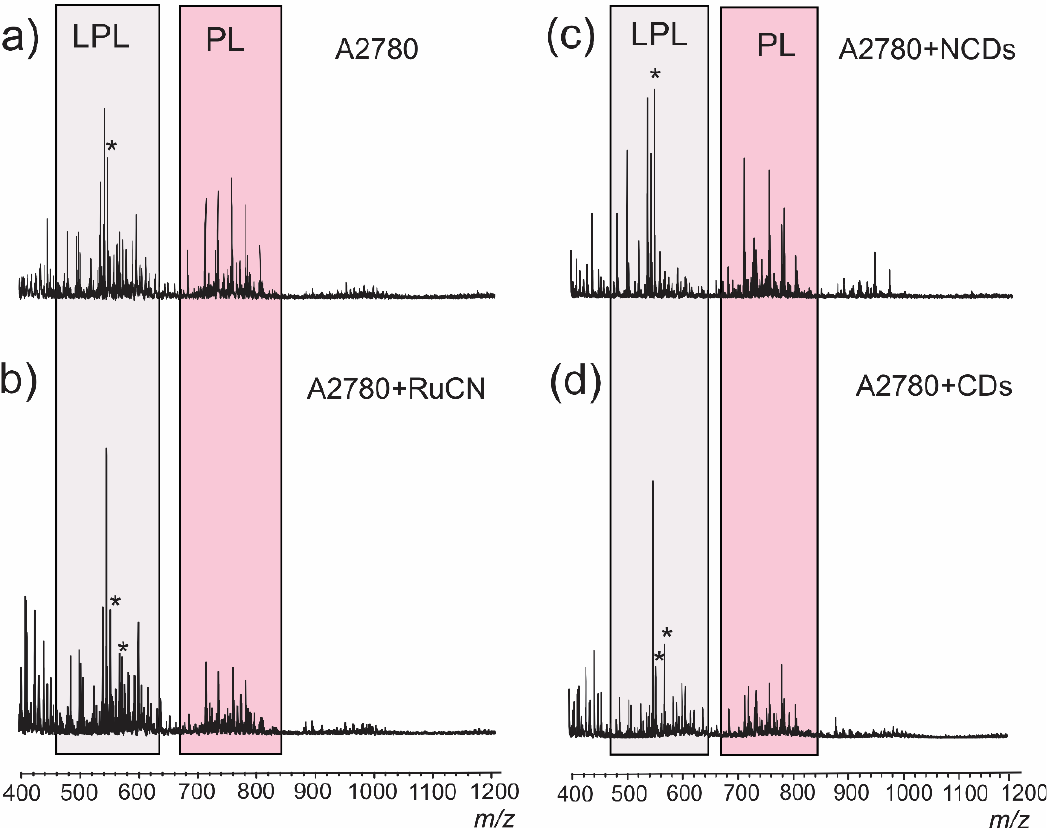
Figure 2. Positive-ion MALDI TOF mass spectra of extracted lipids from the A2780 cancer cell line ( a ) after the treatment with Ru-CN metallodrug ( b ), N-CDs ( c ), and CDs ( d ). Peaks with an asterisk (*) correspond to the higher molecular weight oligomers of the DHB matrix. For the assignment, see Table 2. Table 2. Signal position and the assignment of cation species ( + ) related to lipids obtained from mass spectra. Peaks with an asterisk (*) correspond to the higher molecular weight oligomers of the DHB matrix.